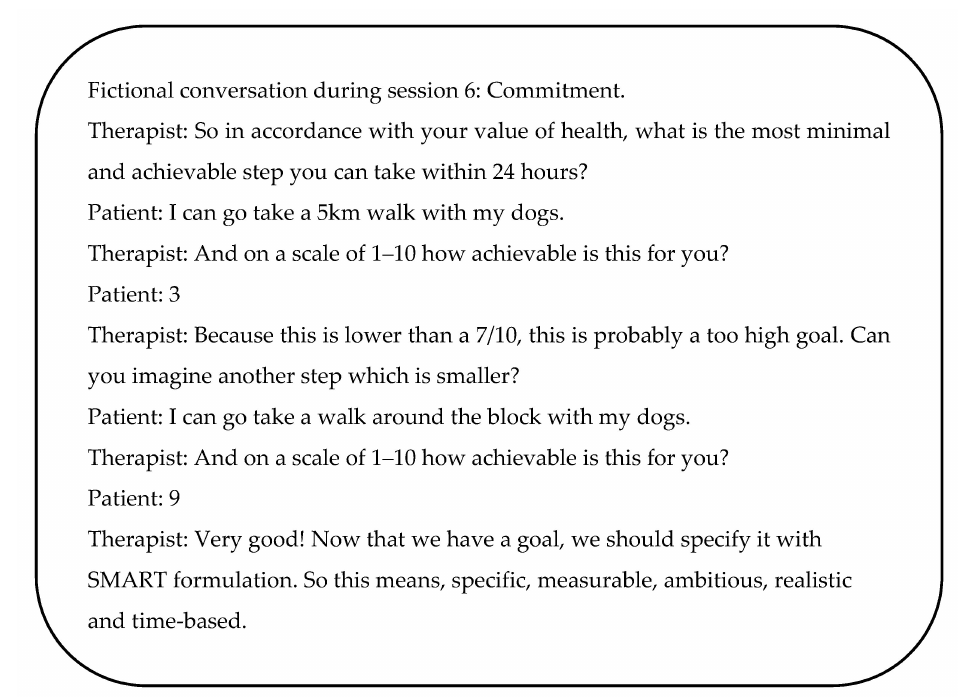
Figure 2. Example of a conversation between therapist and patient related to goal defining. Abbrevi- ations. A: achievable, M: measurable, R: relevant, S: specific, T: